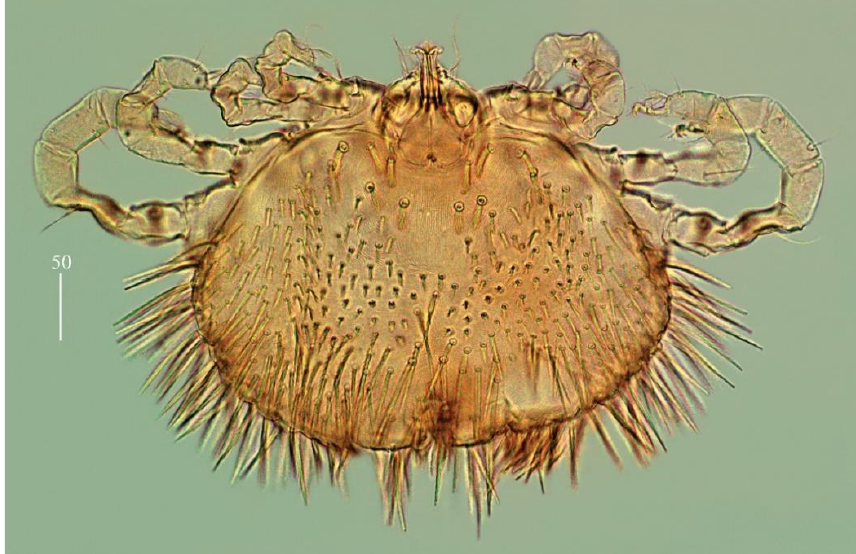
Figure 23. Geckobia phillipinensis Lawrence, 1953 female in dorsal view.